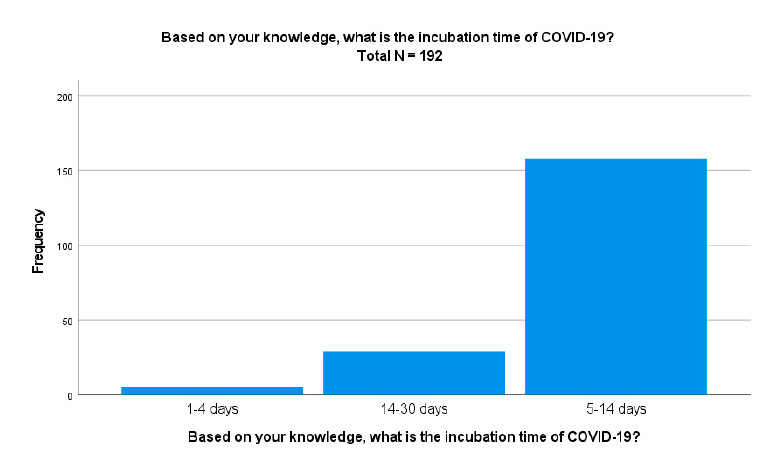
Figure 2. Knowledge based on the incubation period.